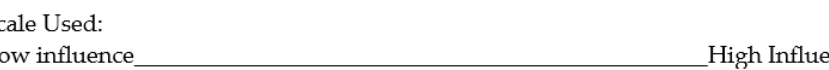
Table 2. Matrix of the themes.